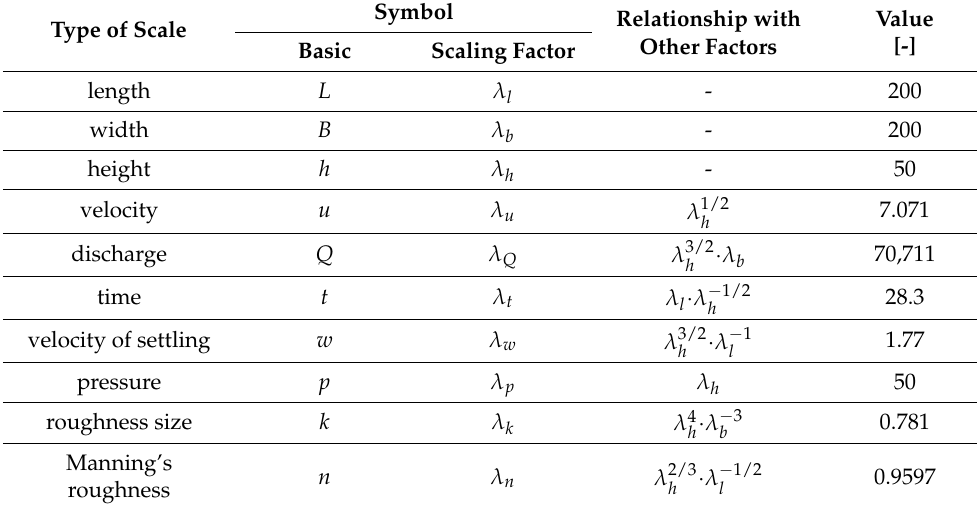
Table 4. Factors applied to scale the model.